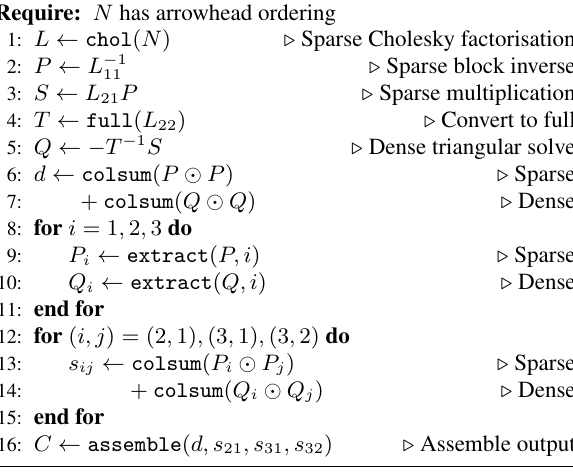
Algorithm 2 The inverse Cholesky algorithm for computing posterior covariance for object points.